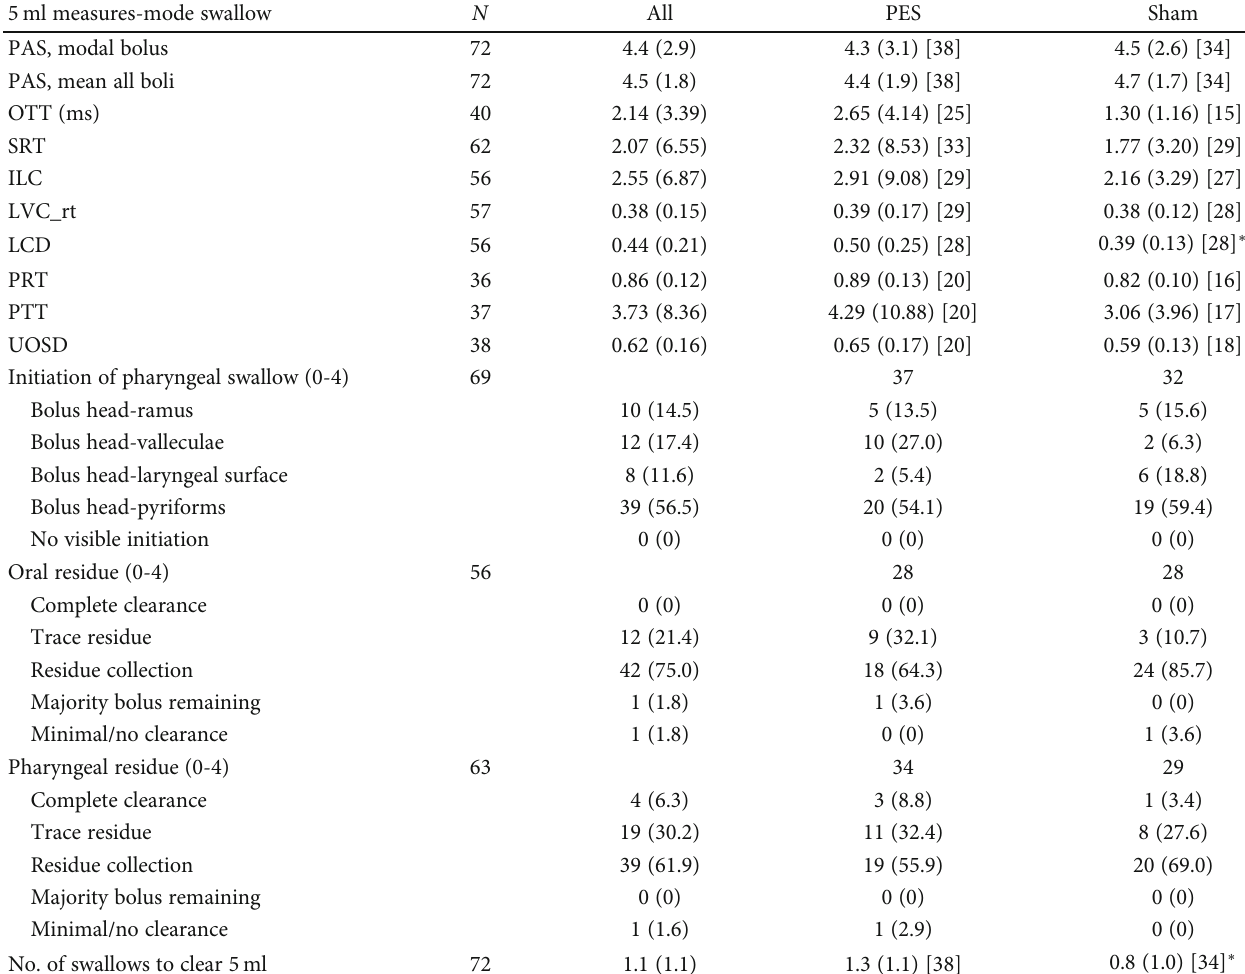
Table 2: VFSS measures at baseline for 5ml mode swallow. Data are number (%) or mean (SD); comparison by Chi-Square (Exact) Test/Fisher ’ s Exact Test or Welch ’ s T